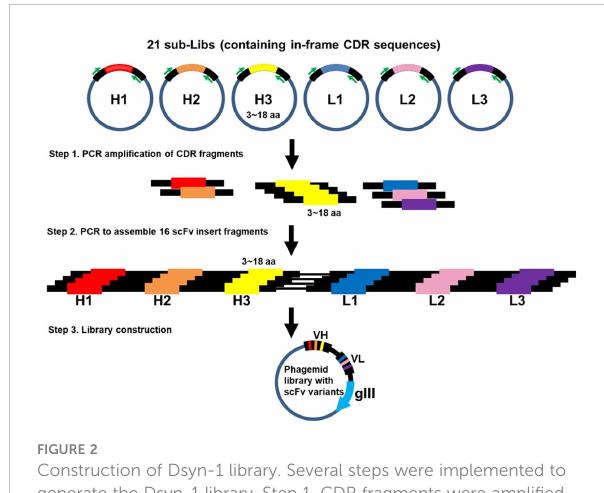
FIGURE 2 Construction of Dsyn-1 library. Several steps were implemented to generate the Dsyn-1 library. Step 1. CDR fragments were ampli fi ed by PCR from 21 sub-libraries (Libs), respectively. Step 2. 6 CDRs, CDRH1 to CDRL3, were assembled into a scFv insert fragment by using two-step overlap extension PCR. Each of the 16 scFv insert fragments was assembled according to different CDR-H3 lengths from 3 to 18 amino acids. Step 3. 16 scFv insert fragments were combined and cloned into